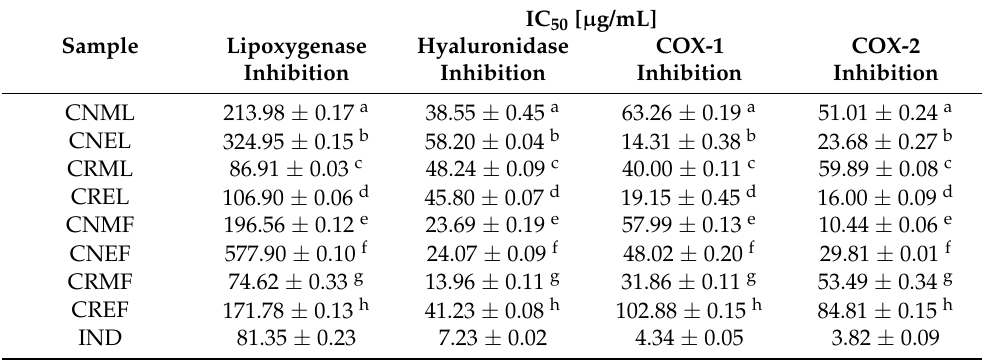
Table 5. Anti-lipoxygenase, anti-hyaluronidase, and anti-cyclooxygenase activities of the leaves and fruits of C. nebrodensis and C. roseus